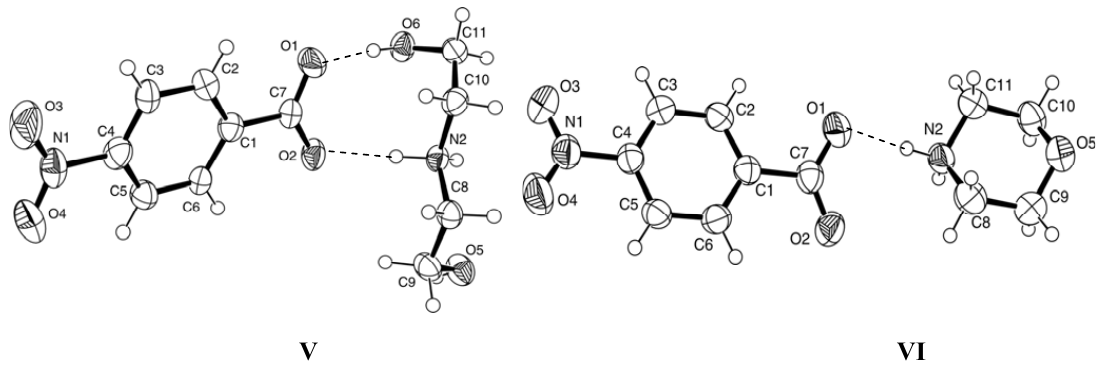
Fig. 1 ORTEP drawing for I-VI with the atomic labeling and charge-assisted hydrogen bonds represented by dashed lines. Thermal ellipsoids are shown with the 50 % probability